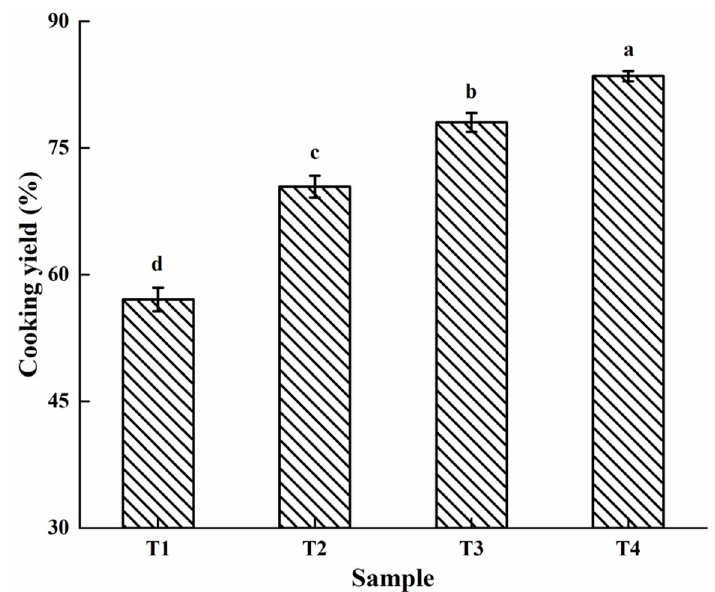
Figure 1. The cooking yield of the PSE meat myofibrillar proteins with varying amounts of added sodium bicarbonate. T1, 0/100 g sodium bicarbonate; T2, 0.2/100 g sodium bicarbonate; T3, 0.4/100 g sodium bicarbonate; T4, 0.6/100 g sodium bicarbonate. Each value represents the mean value ± SE ( n = 3). a–d Different parameter superscripts in the same column indicate significant differences ( p <